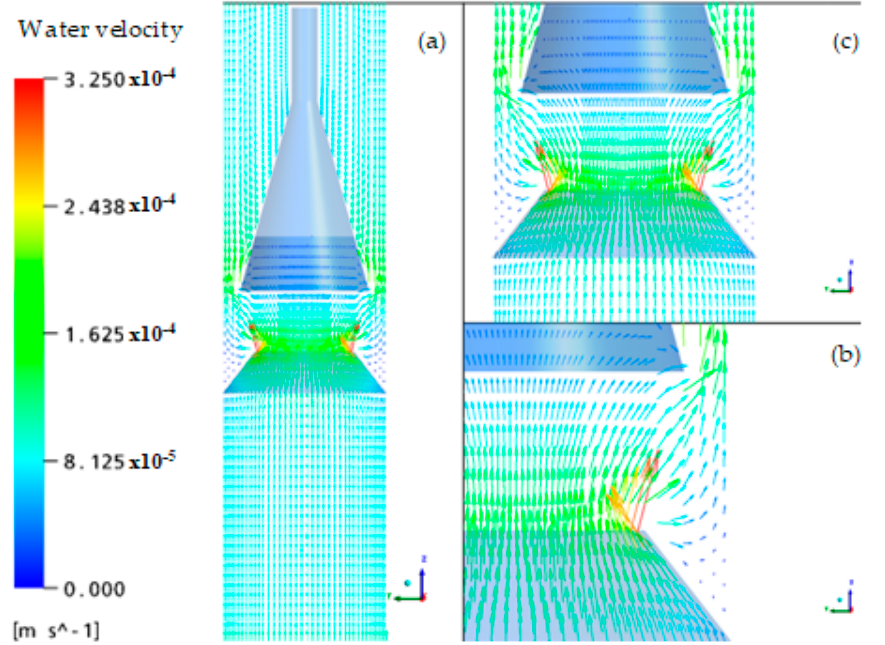
Figure 6. Water velocity vector in the reactor with deflector inclination upwards: ( a ) overview, ( b ) detail of the region between the gas deflector and the three-phase separating element, and ( c ) detail of the region corresponding to the settling zone.